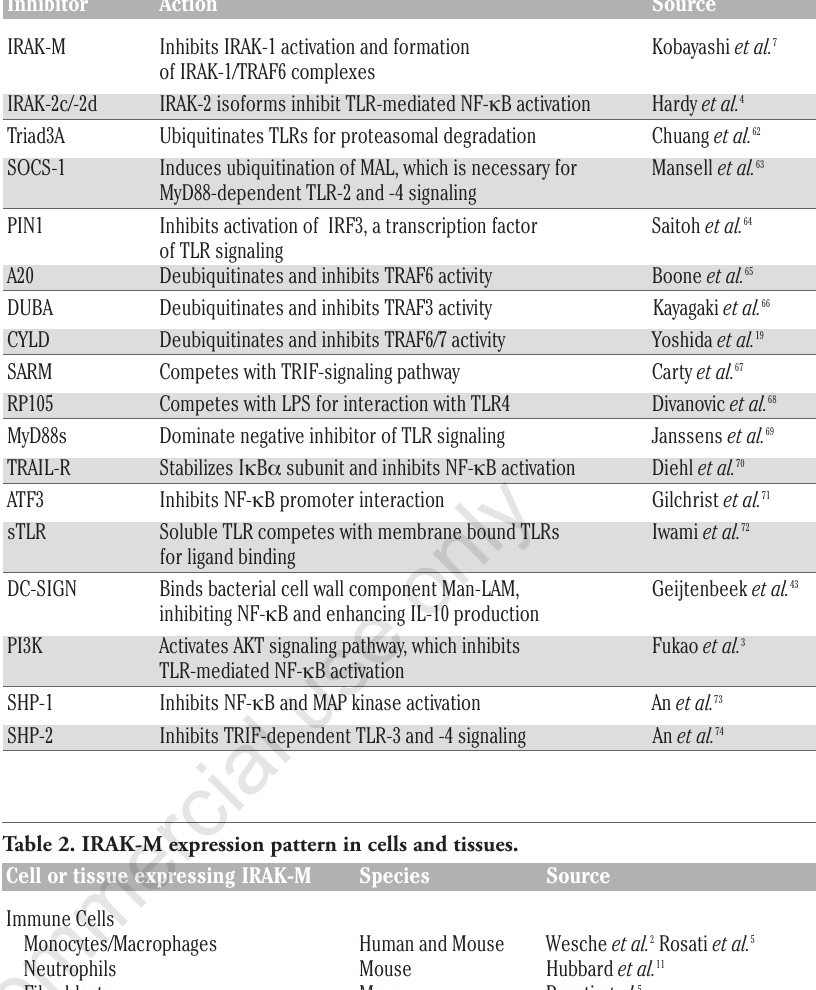
Table 1. Negative regulators of TLR/IL-1R signaling.